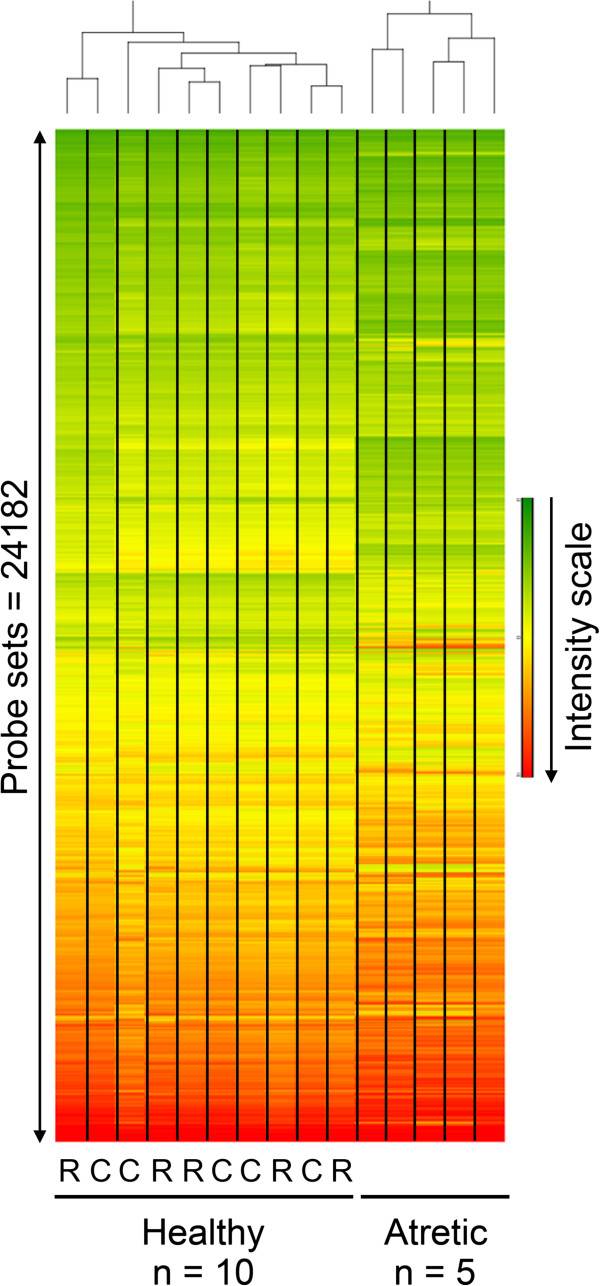
Unsupervised hierarchical clustering across all probe sets (n = 24,182) for 15 arrays using the Euclidian dissimilarity algorithm with the average linkage method in Partek Genomics Suite. The heatmap represents the distribution of normalised signal intensity, grouping by pattern similarity for both probe set and array. (R = rounded and C = columnar phenotypes).